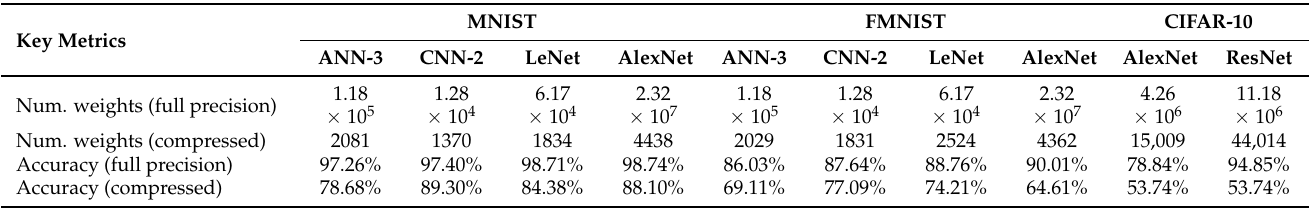
Table 2. Model size in terms of number of weights and accuracy reported for full-precision and compressed versions of the various